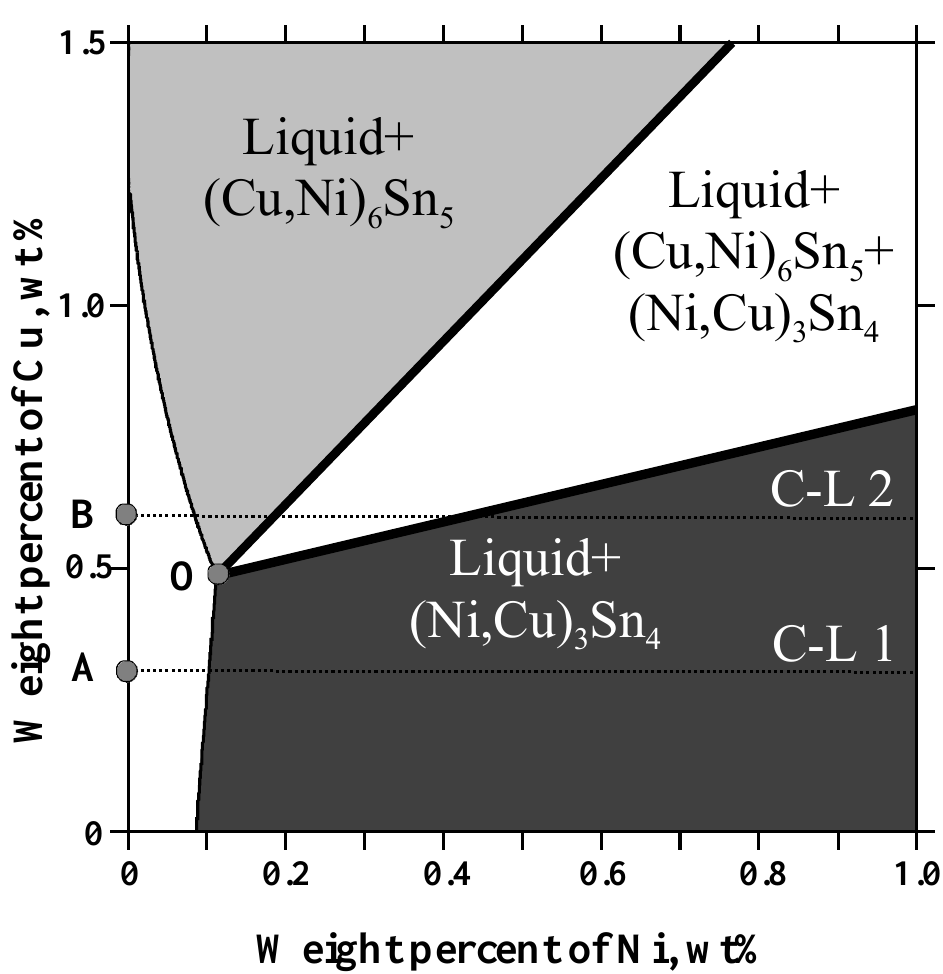
Figure 10. Tin-rich corner of the Sn-Cu-Ni phase diagram at 250